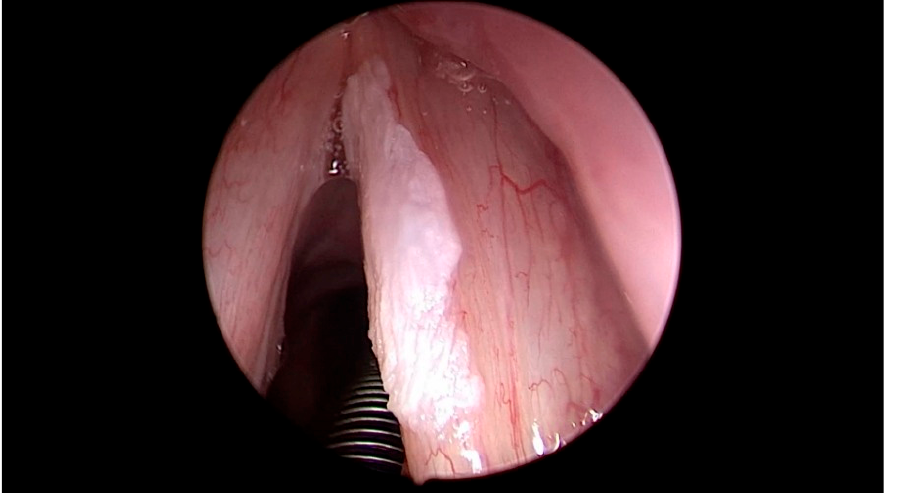
Figure 6. Histologically-verified parakeratosis of the right vocal cord presenting as leukoplakia. Young scoring system—3 points, Fang scoring system—3 points, Zhang type I—flat and smooth.